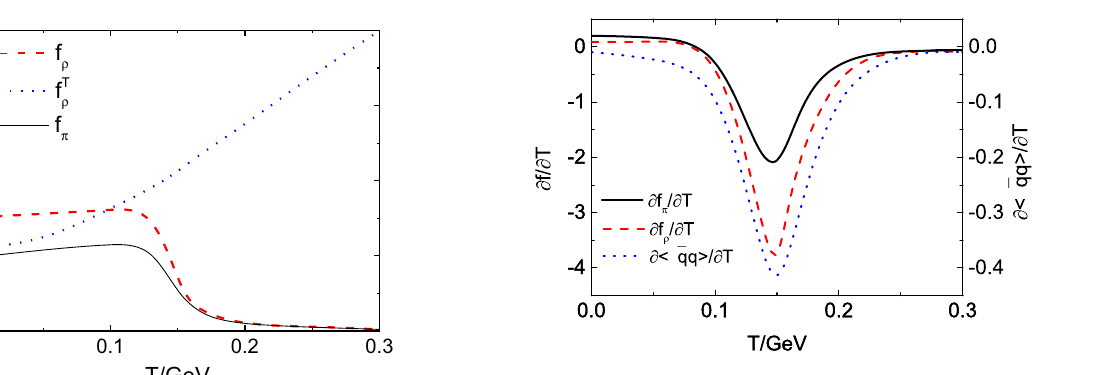
Fig. 4 Temperature derivative of decay constants f π ( solid curve ) and f ρ ( dashed curve ), along with quark chiral susceptibility χ = ∂ (cid:4)¯ qq (cid:5) /∂ T ( dotted curve ) which is in a range from 147 to 165 MeV in Ref. [76,77] and T lQCD c = ( 154 ± 9 ) MeV in Ref.